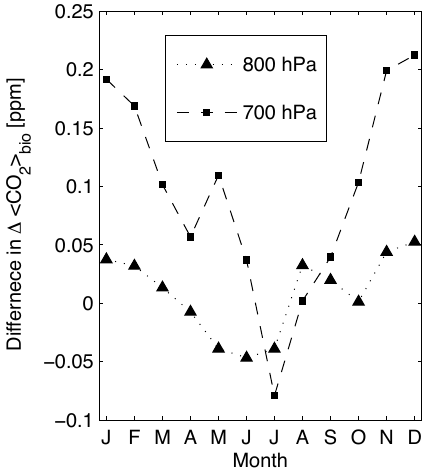
Fig. 16. Daily mean NEE at 270 ◦ W, 60 ◦ N for boreal-enhanced CASA fluxes (gray) and long boreal growing season (black). July NEE has been added to May to hasten the onset of the growing season in spring, and the net flux of carbon to the atmosphere is increased outside the growing season to balance the fluxes.